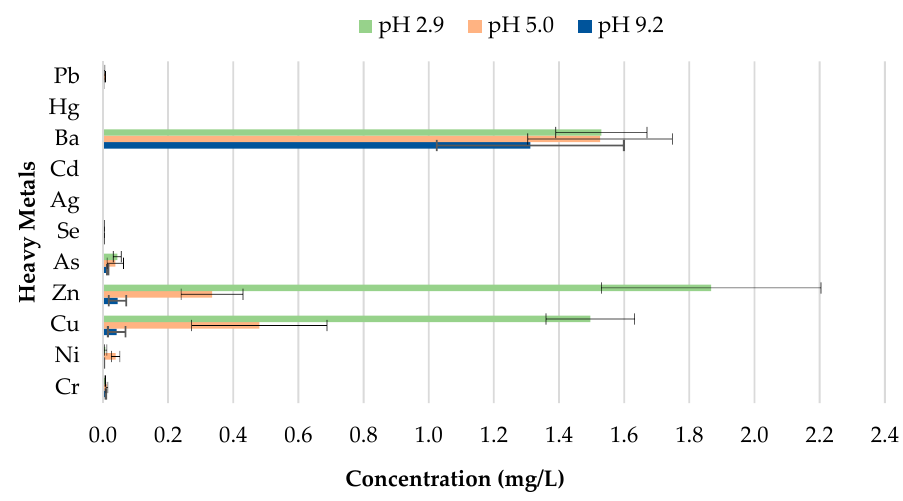
Figure 14. Leachate concentrations for crushed bricks with 1.5% CB content.